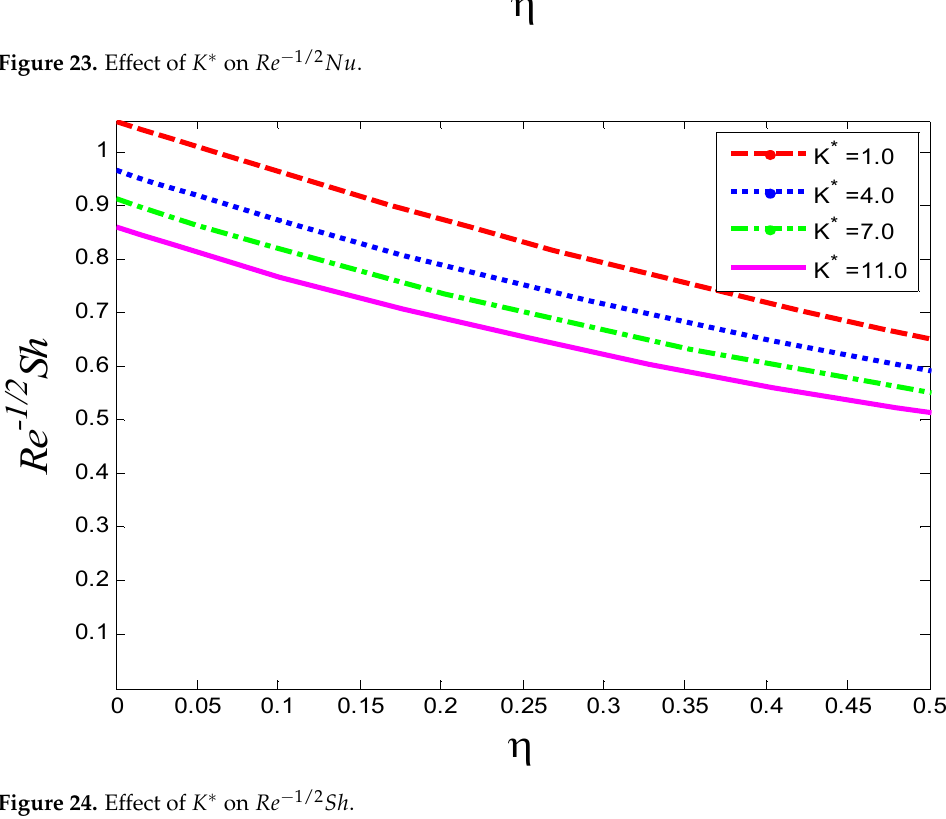
Figure 24. Effect of K ∗ on Re − 1/2 Sh